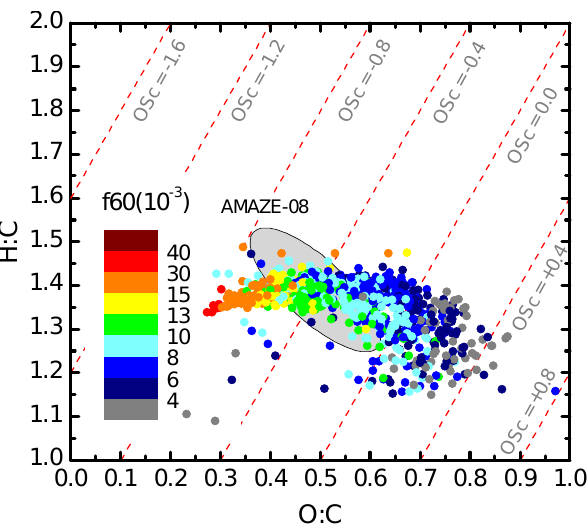
Figure 7. Representation of the OA components into the VK tri- angle diagram. The estimated carbon oxidation states (OS C ≈ 2 × O / C − H / C) are shown as red dotted lines. The gray area indicates the V-K space from AMAZE-08 as described by Heald et al. (2010).